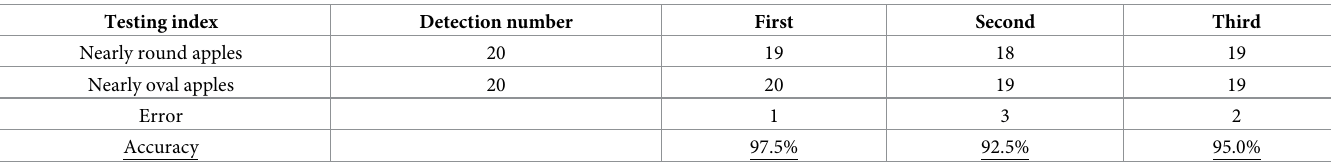
Table 2. Results of detection for apple